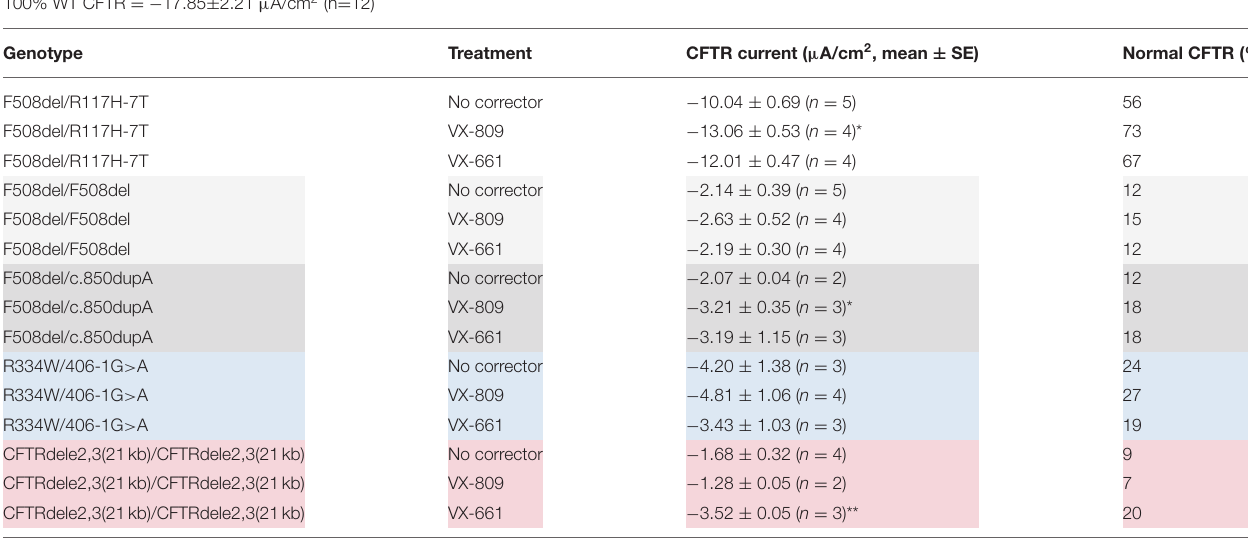
TABLE 2 | Summary of CFTR measurements in EpiX TM expanded CF nasal cultures.